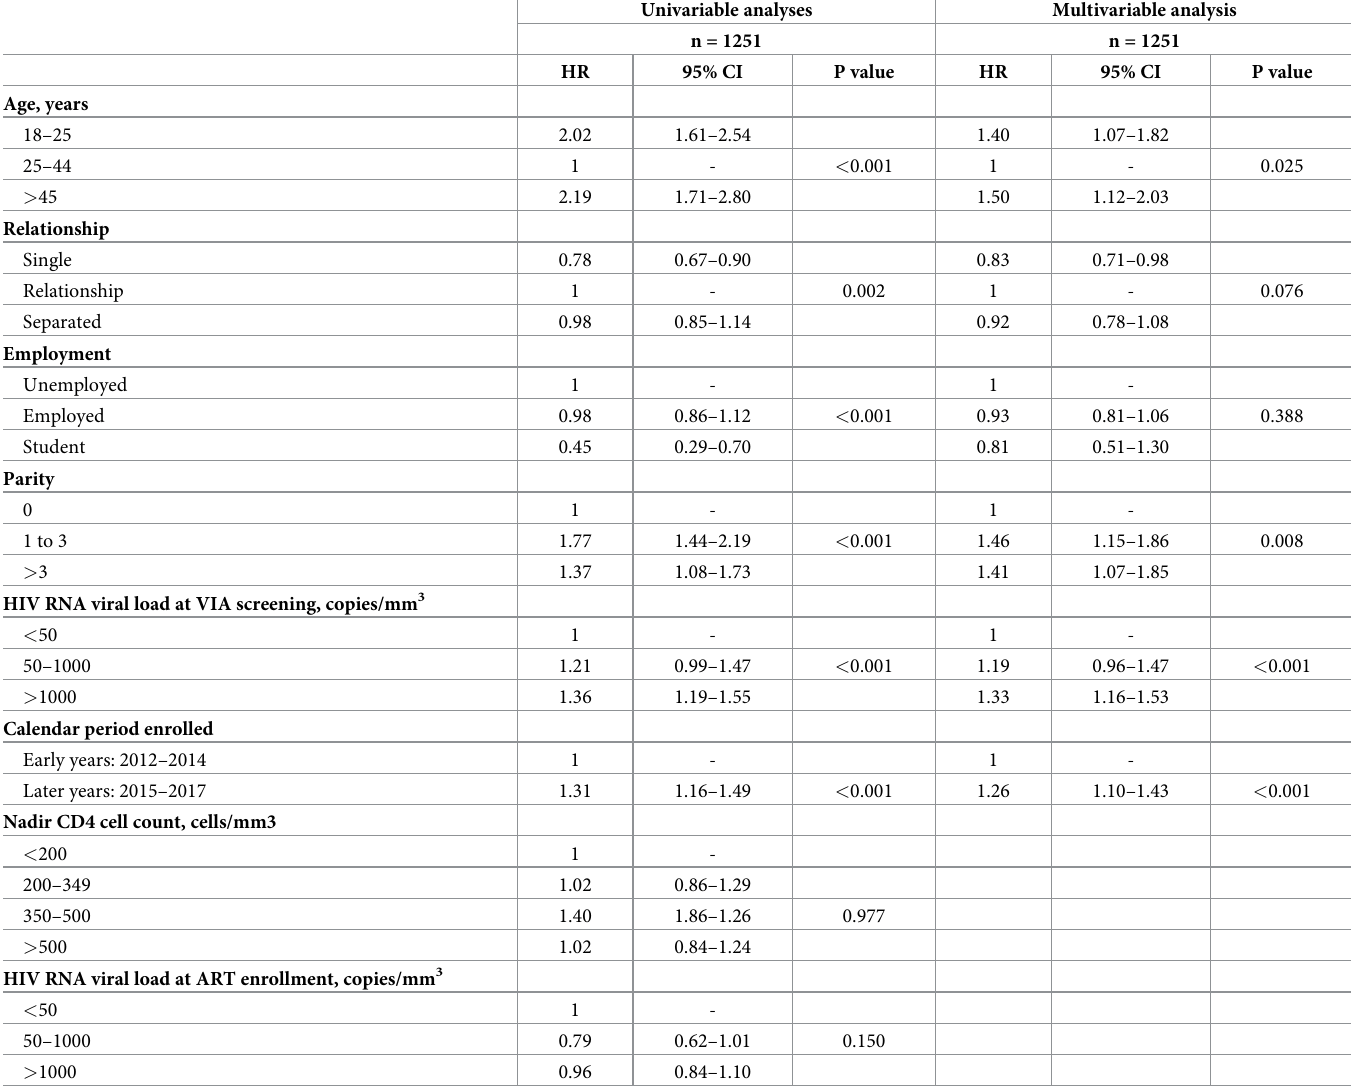
Table 2. Crude and adjusted hazard ratios for factors associated with retention in the Cervical Cancer Screening